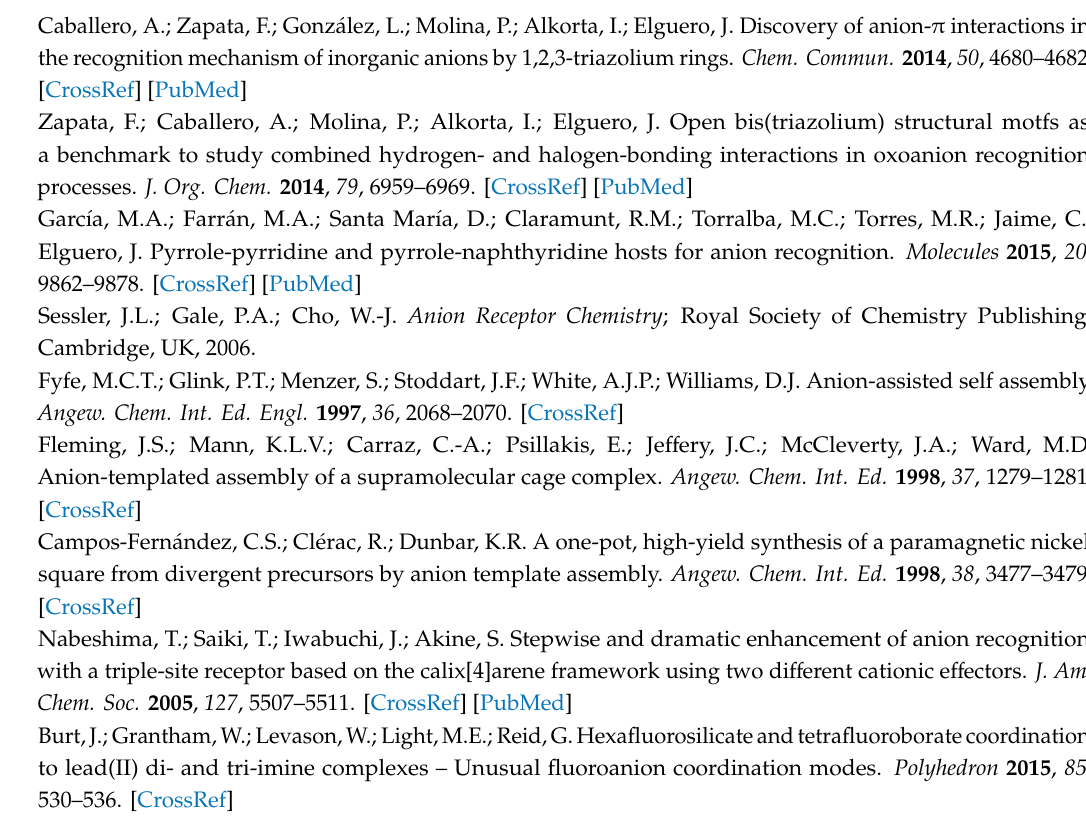
binding studies including titrations and Job plots experiments as well as computational